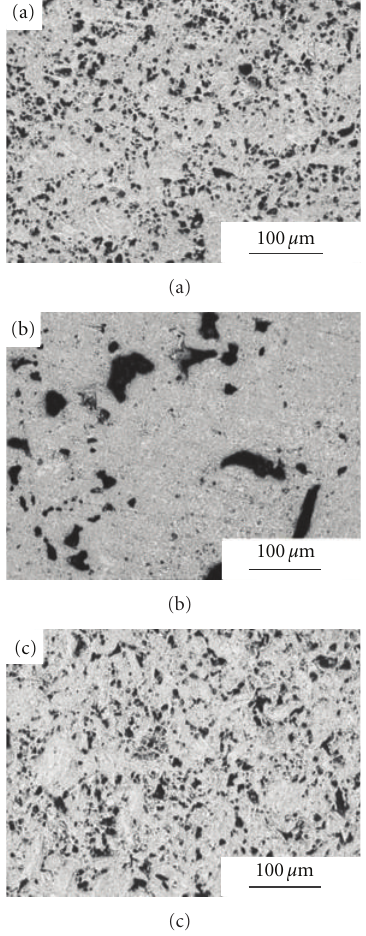
Figure 2: Morphology of graphite samples before irradiation.